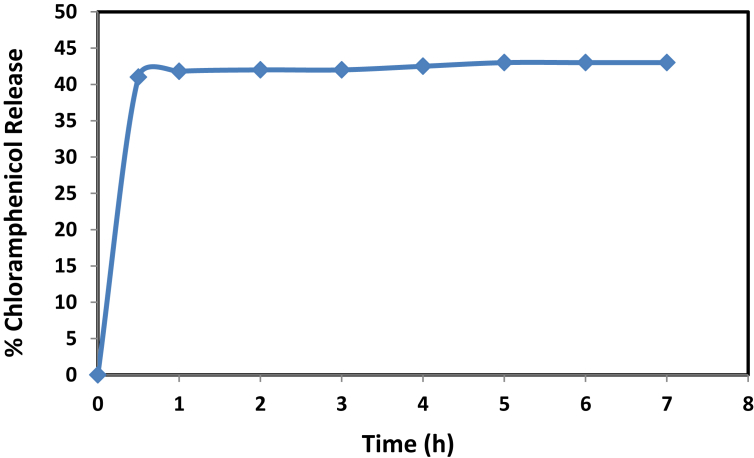
The chloramphenicol release profile of NH2-SBA-15 sample.